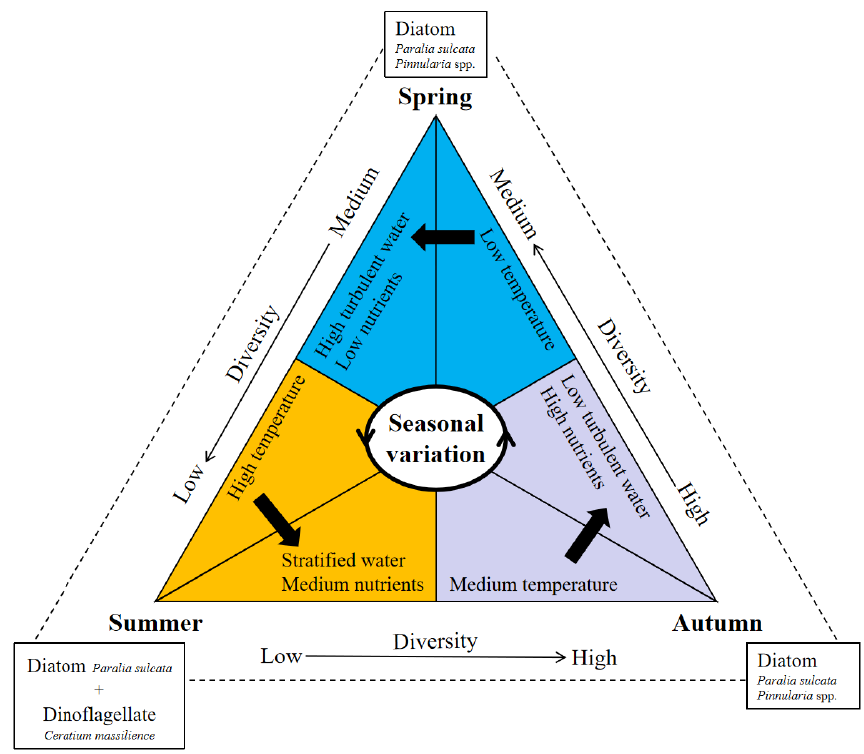
Figure 10. Schematic of seasonal succession of the phytoplankton community in the BS and NYS.